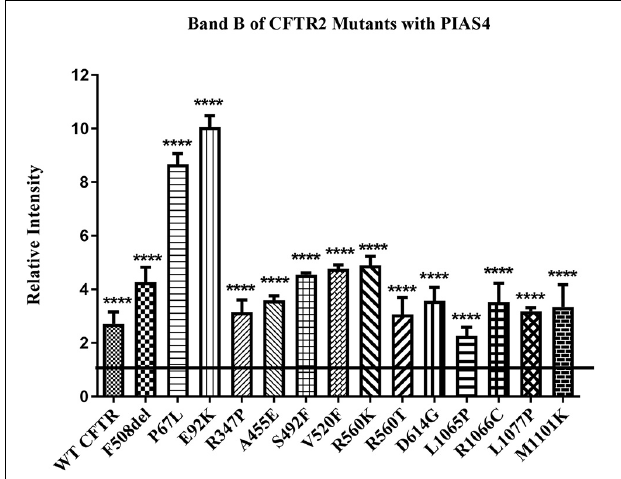
FIGURE 3 | Effect of PIAS4 on band B expression in CFTR2 mutants. CFBE41o- cells were transfected with a CFTR2 mutant with or without PIAS4. SDS–PAGE was performed, and intensities of the bands were analyzed on a Li-Cor Odyssey IR imaging system. The control band B level for each mutant was set to a value of 1.0, depicted by the horizontal line, whereas the height of each bar represents band B level relative to that of the control. PIAS4 co-expression increased band B intensity for each mutant. **** P <